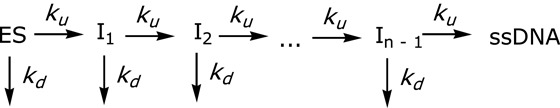
Unwinding data was fit to an n-step sequential mechanism where ES is the enzyme substrate complex, I is a partially unwound intermediate, ssDNA is the product, ku is the rate constant for unwinding, kd is the rate constant for dissociation, and n is the number of steps.